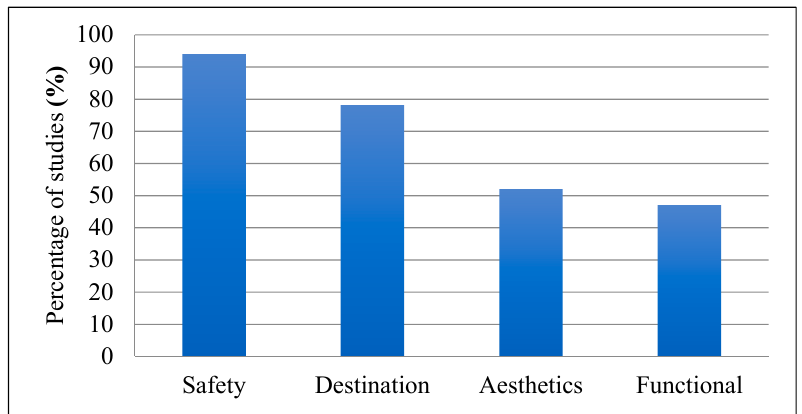
Figure 1. Percent of included studies ( n = 36) categorized by reported key built environment features.